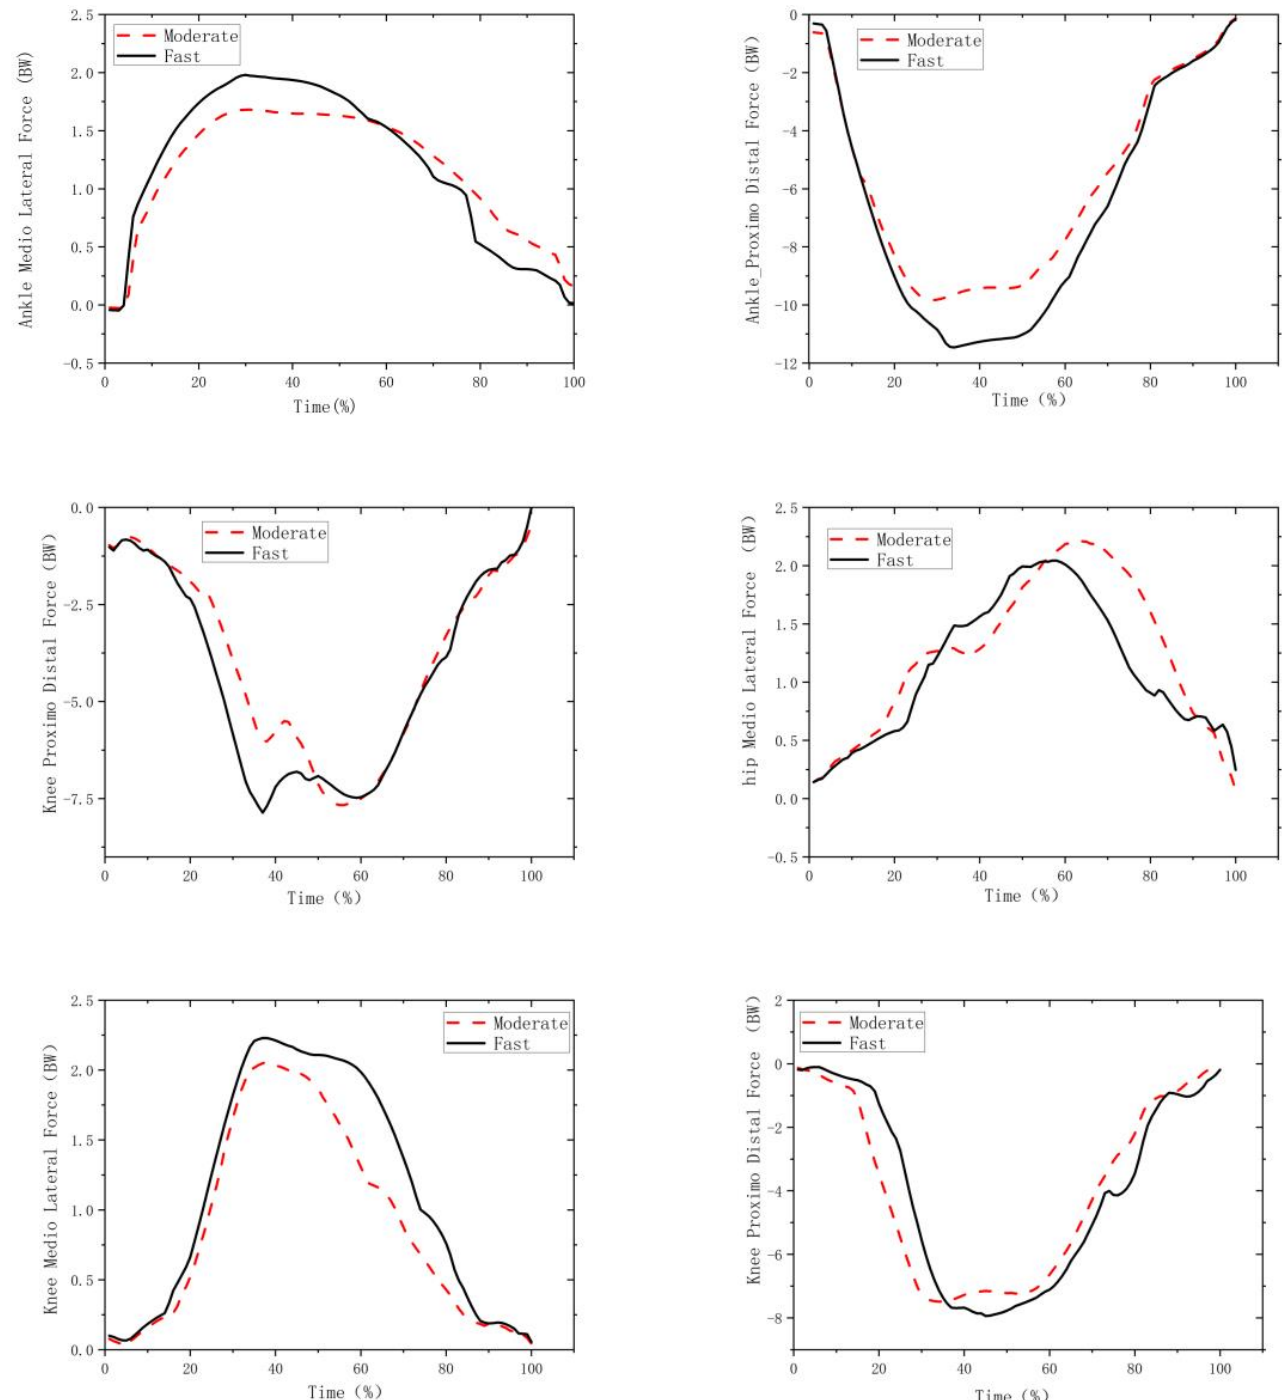
Figure 4. The curves of the medial–lateral (left) and proximal–distal (right) contact forces of ankle (upper), knee (middle) and hip (bottom) joints across time. Table 4. The hip, knee and ankle medial–lateral and proximal–distal contact forces (N/BW) in each analyzed event.